Question: In one sentence, what is this figure communicating?
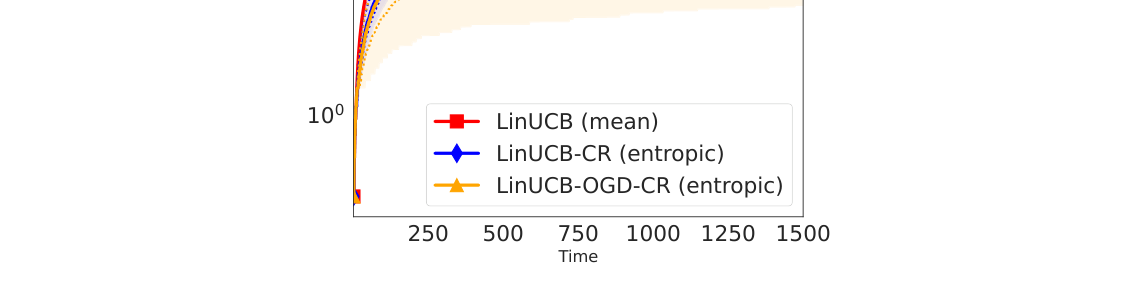
Answer: 1 – Left: two-armed Gaussian expectile bandit. Center: two-armed linear expectile bandit with R3 contexts and expectile-based asymmetric noises. Right: two-armed Bernoulli entropic risk bandit. Thick lines denote median cumulative pseudo regret over 500 independent replicates. Dotted lines denote the 25 and 75 pseudo regret percentiles. Shaded areas denote the 5 and 95 percentiles.